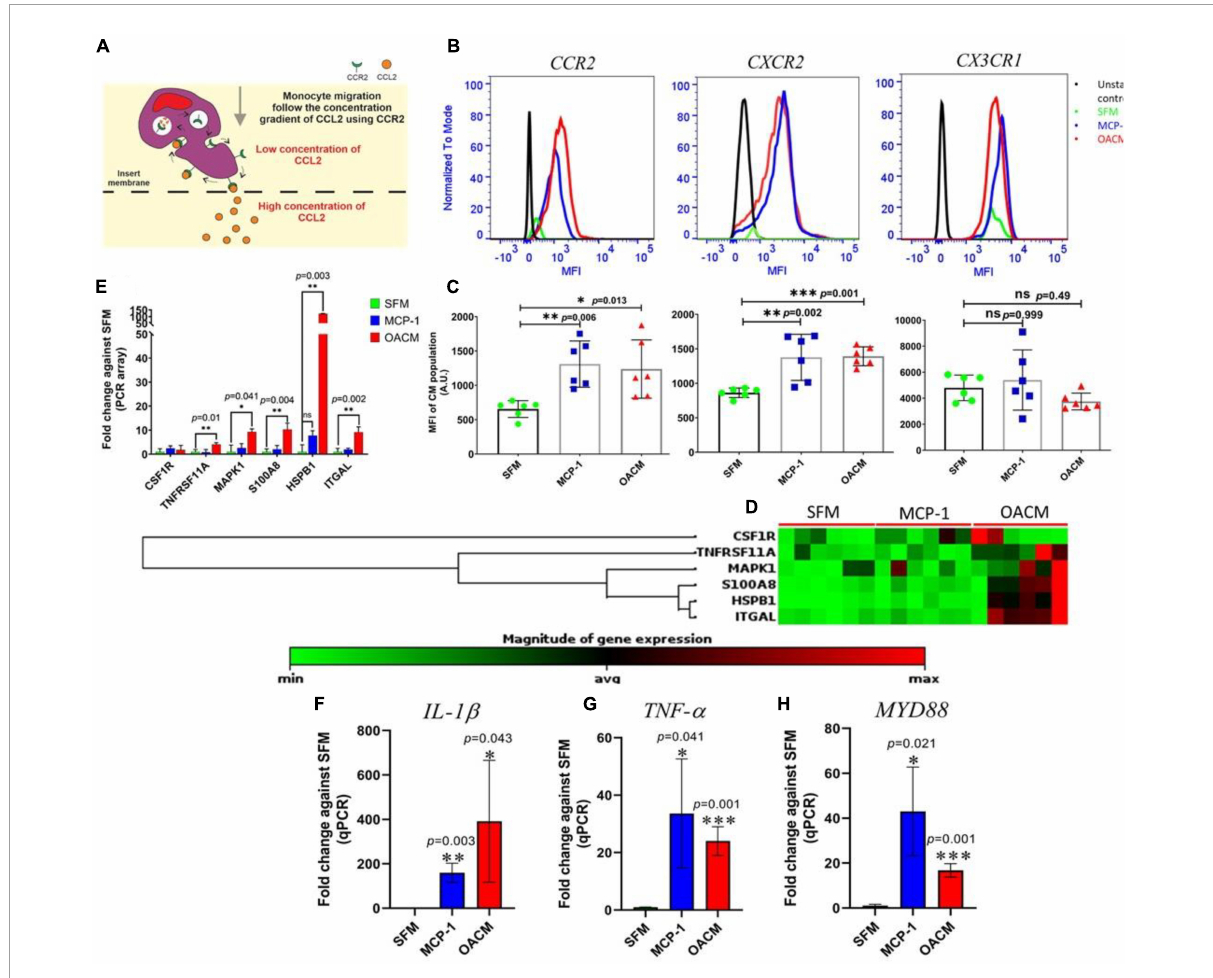
FIGURE6 The chemotaxis and the pro-inflammatory response of monocytes to SFM, MCP-1, and OACM. (A) Transwell migration model of monocytes using CCR2 receptor binding with CCL2 in concentration gradient. (B) The flow cytometry histogram profile of CCR2, CXCR2, and CX3CR1 receptors. (C) The statistical analysis of the expression of CCR2, CXCR2, and CX3CR1. (D) Heatmap of gene expression array. (E) The fold-change in gene expression array. (F–H) Fold-change of gene expression in qPCR. The assessments were reported to be statistically significant if * p < 0.05, ** p < 0.01 and *** p <